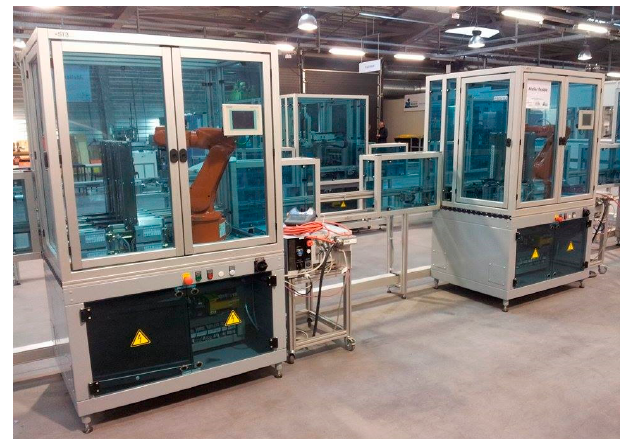
Figure 3. The Petri net model.